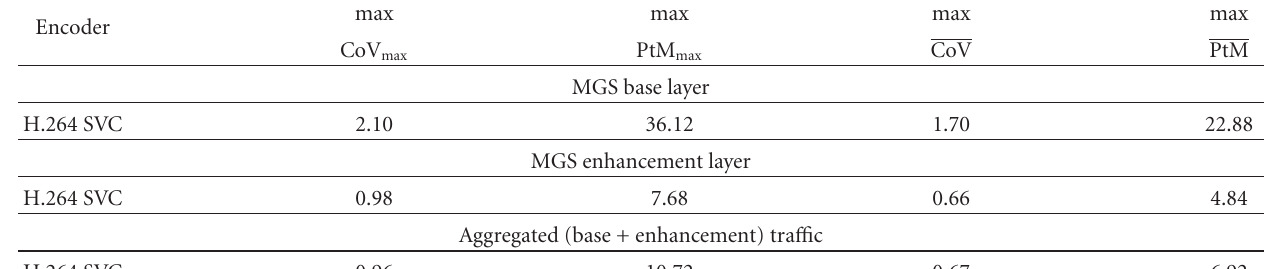
Table 9: Maximum- (across quantization scales) of-maximum (across five video sequences), and maximum-of-mean CoV and PtM values of H.264 SVC MGS base and enhancement layers, and aggregated tra ffi c. Encoder